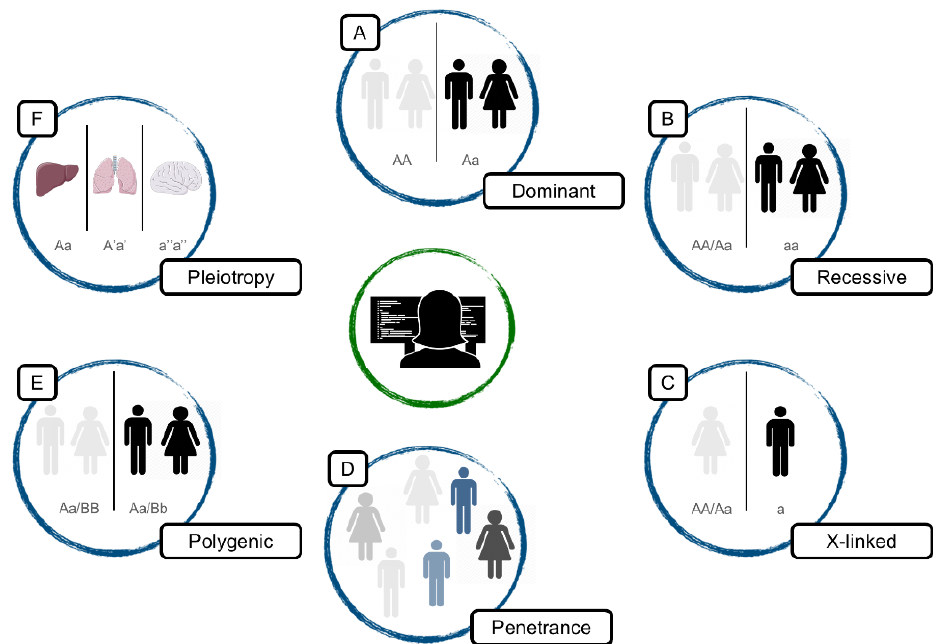
Figure 1. Examples of gene effect complexity. ( A ). Dominant: a single mutated allele is enough to cause the disorder ( B ). Recessive: two mutated alleles are required to cause the disorder ( C ). X-linked: males that carries the disease-causing mutation are affected due to the single copy of the X chromosome ( D ). Penetrance: same genetic variant might not develop the same symptomatology in different individuals ( E ). Polygenic: disorder caused by the combined action of more than one gene ( F ). Pleiotropy: mutations in a single gene affects two or more apparently unrelated